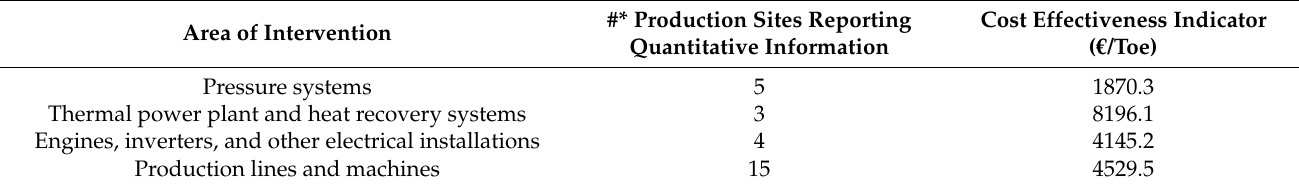
Table 6. Cost-effectiveness indicator for each area of intervention.